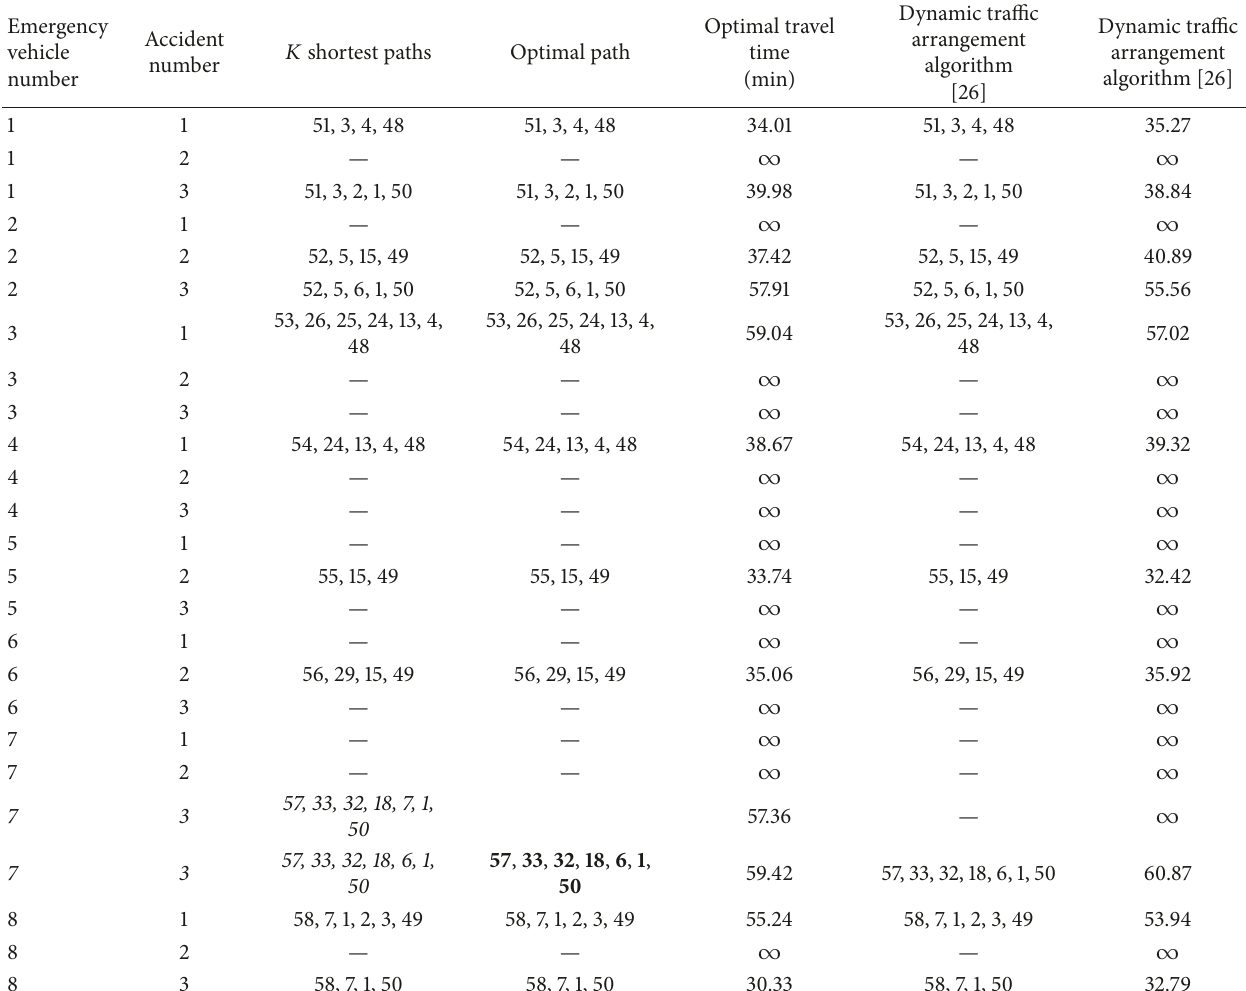
Table 5: Results of the 𝐾 shortest paths selection.